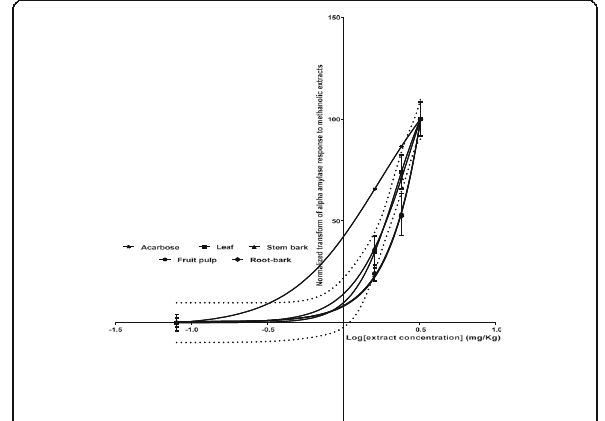
Fig. 3 Dose-response curve of α -amylase inhibition by methanolic